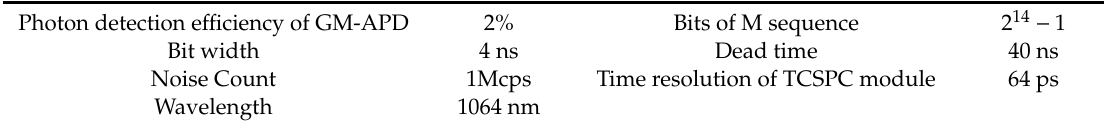
Table 2. Main experimental parameters.